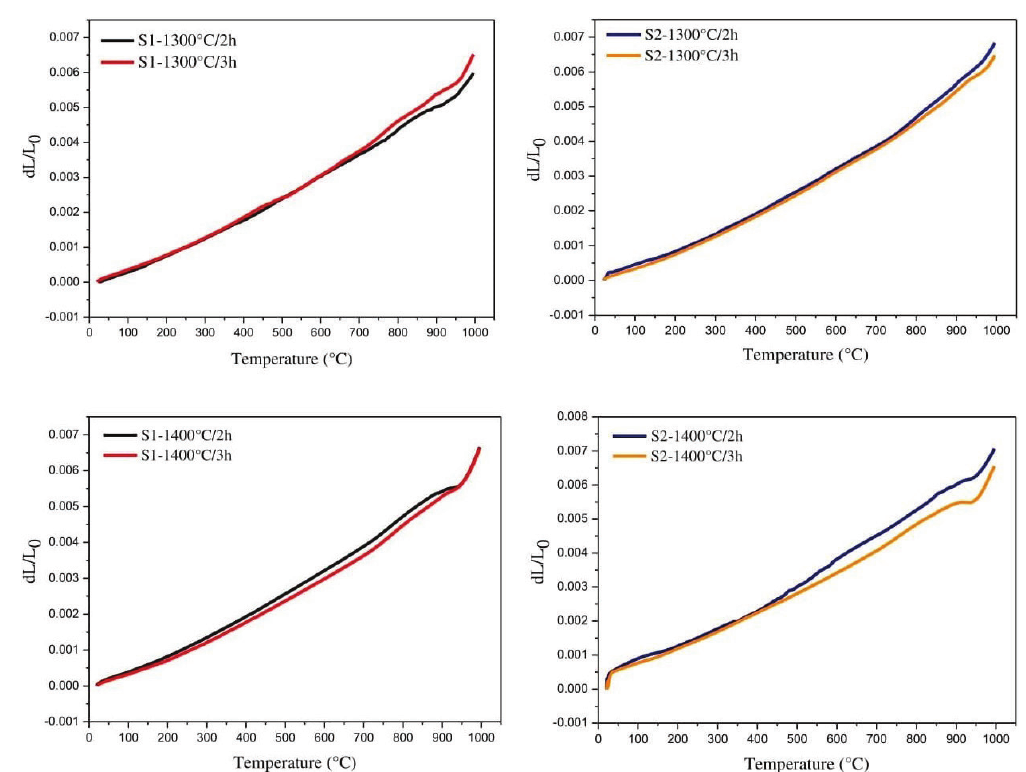
Figure 6. Thermal expansion curves of formulations S1 and S2 previously sintered at 1300 and 1400°C.